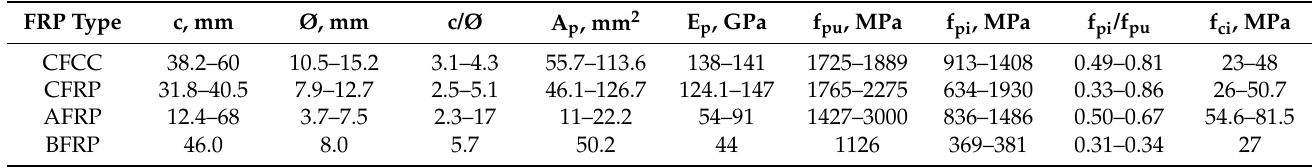
Table 3. Initial parameters of the transfer length versus